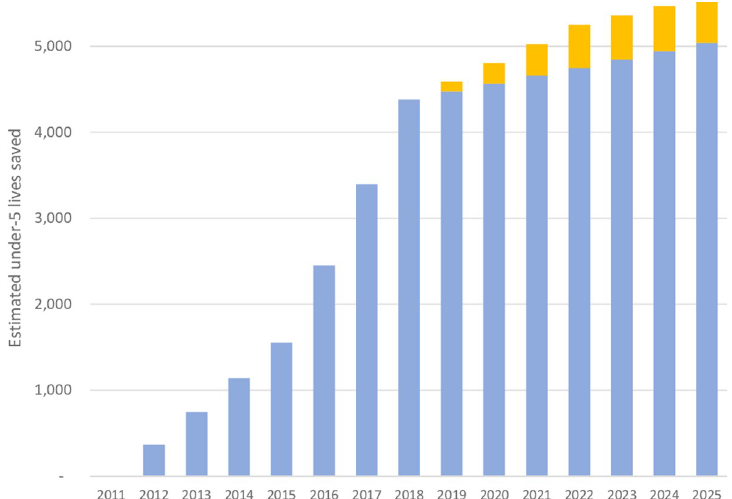
Fig 4. Estimated additional under-5 lives saved based on changes in household ownership coverage of ITNs, 2012–2025. The blue bars show maintaining 2018 coverage levels through 2025. The orange bars show the projected number of under-5 lives saved if provinces with � 85% household ITN coverage reach 85% by 2022 and maintain 85% coverage until 2025, and if the 5 provinces that exceeded 85% coverage by 2018 maintain their 2018 coverage levels through 2025.